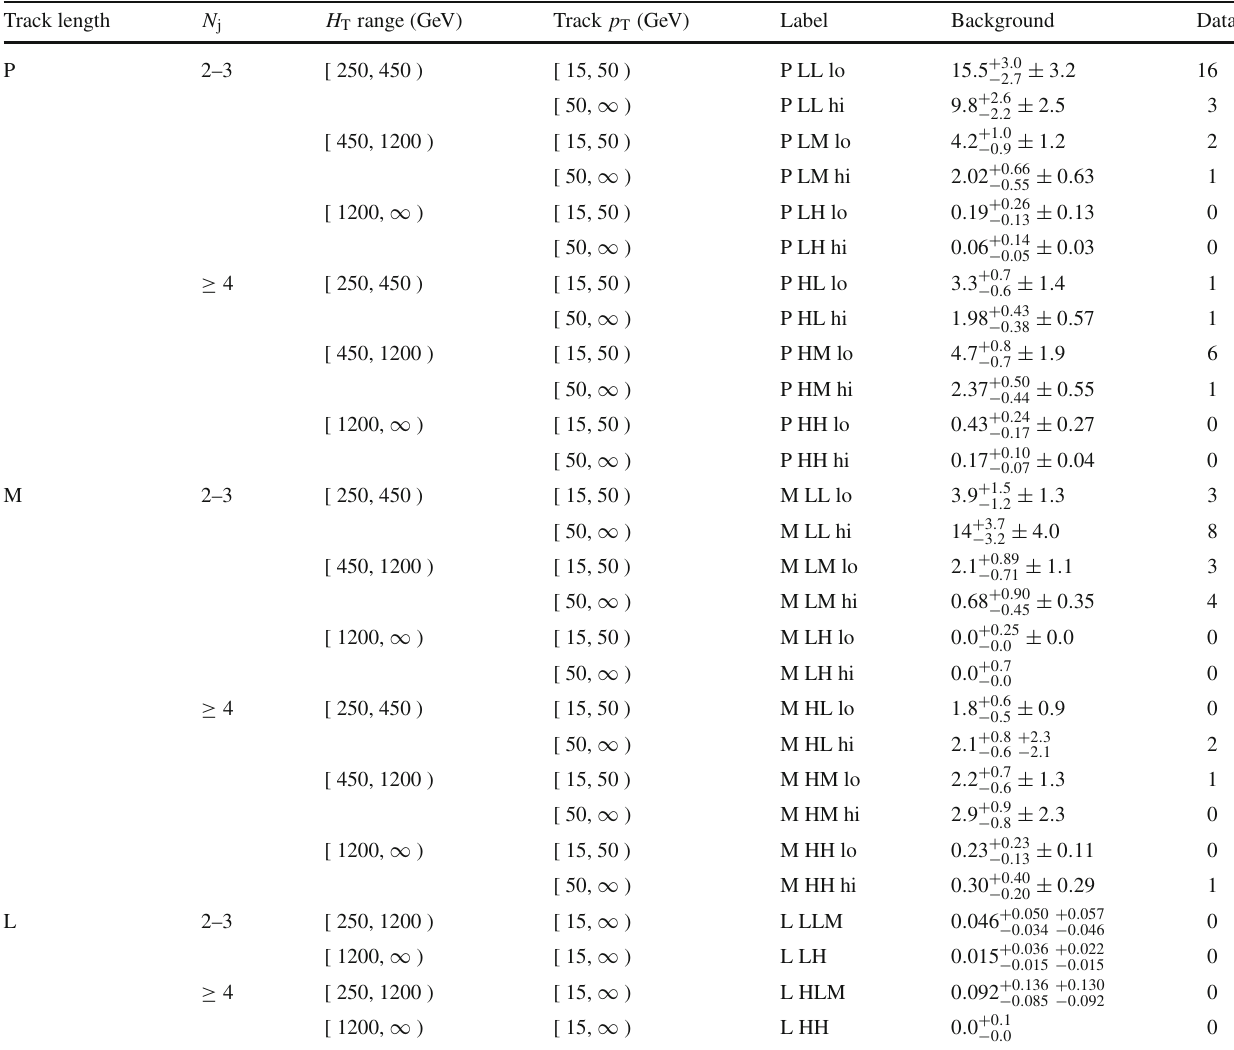
Table 24 Summary of the 28 signal regions of the search for disap- pearing tracks, for the 2016 data set, together with the corresponding background predictions and observations. For the background predic-